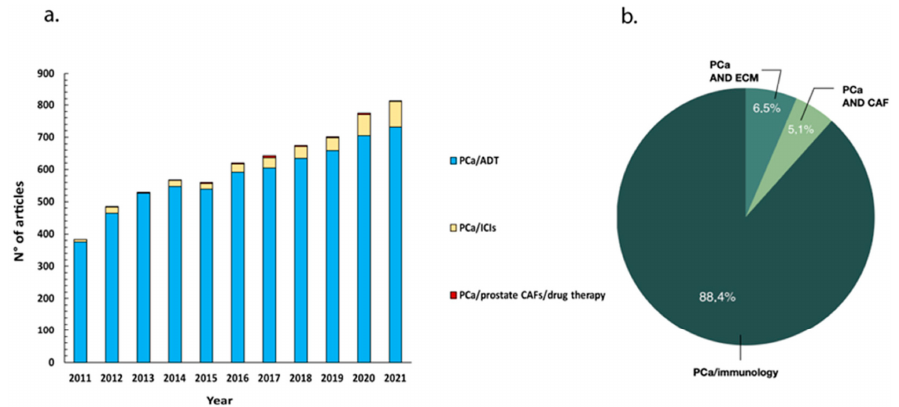
Figure 1. Therapeutic strategies targeting prostatic stromal microenvironment. ( a ) Search for ar- ticles appearing in PUBMED over the past 10 years (2011–2021) using the mesh terms “prostatic neoplasm/prostate CAFs/drug therapy” (red); “prostatic neoplasm/ICIs” (yellow); and “prostatic neoplasm/ADT” (blue). In the last 10 years, publications regarding therapies targeting the major components of TME have developed. ( b ) Search for articles appearing in PUBMED using the mesh terms “prostatic neoplasm” AND “extracellular matrix” (6%), “prostatic neoplasm” AND “cancer- associated fibroblast” (5%), and “prostatic neoplasm/immunology” (88%). Among PCa therapies against the major components of TME, immune therapies represent the most frequently searched, indicating a lack of research on CAFs in